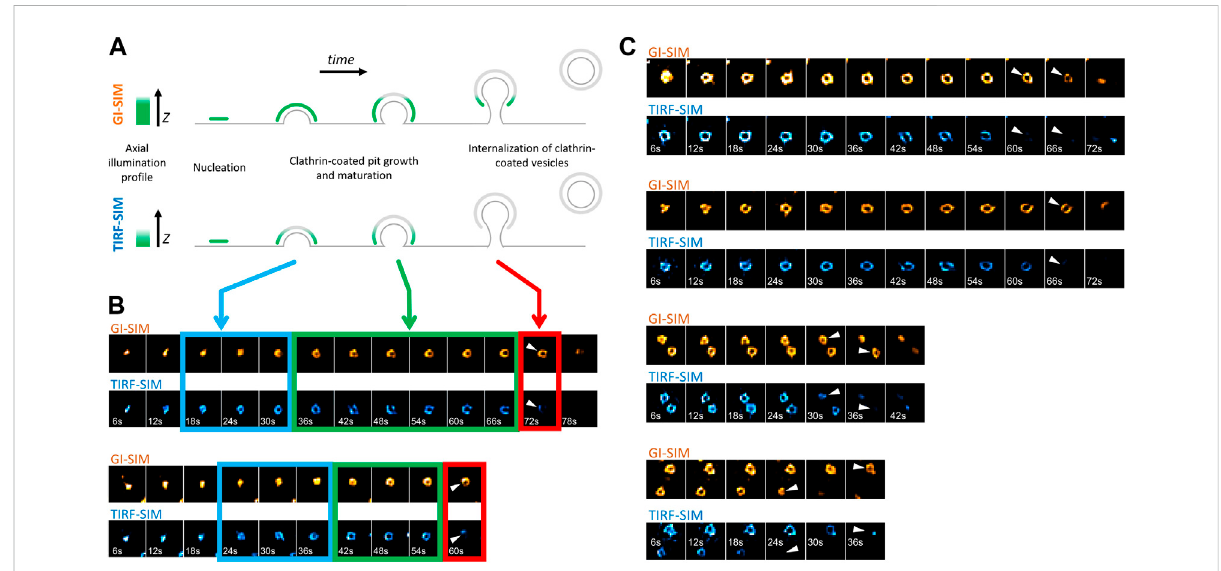
FIGURE 1 Formationandinternalizationof “ canonical ” clathrin-coatedpits(CPs)asdetectedbysimultaneoushighNATIRF-SIM&GI-SIMimaginginliving cells. (A) GI-SIM offers longer penetration depth, i.e., fl uorescence excitation along the z -dimension, compared to TIRF-SIM. As invagination of the endocytic pit increases, the apex of the clathrin coat exits the excitation fi eld of TIRF-SIM earlier, resulting in emergence of the ring pattern (blue boxesinB).Asthecoatmaturesintoapit,itisobservableasaringinbothchannels(greenboxesinB).Whilethecoatisinternalizedasawhole,it leaves the TIRF fi eld but still can be observed in the GI-SIM channel (red boxes in B). (B) Montages show formation and internalization of two CPs as imaged by GI-SIM and TIRF-SIM simultaneously in SUM159 cells genome edited to express AP2-EGFP. (C) More examples displaying the inward movement of CPs and their internalization as a whole, i.e., without splitting into multiple fragments. Arrowheads mark disappearance of the clathrin pits from the TIRF-SIM channel while they are still observable by GI-SIM. Each region of interest in B and C, 1 µm × 1